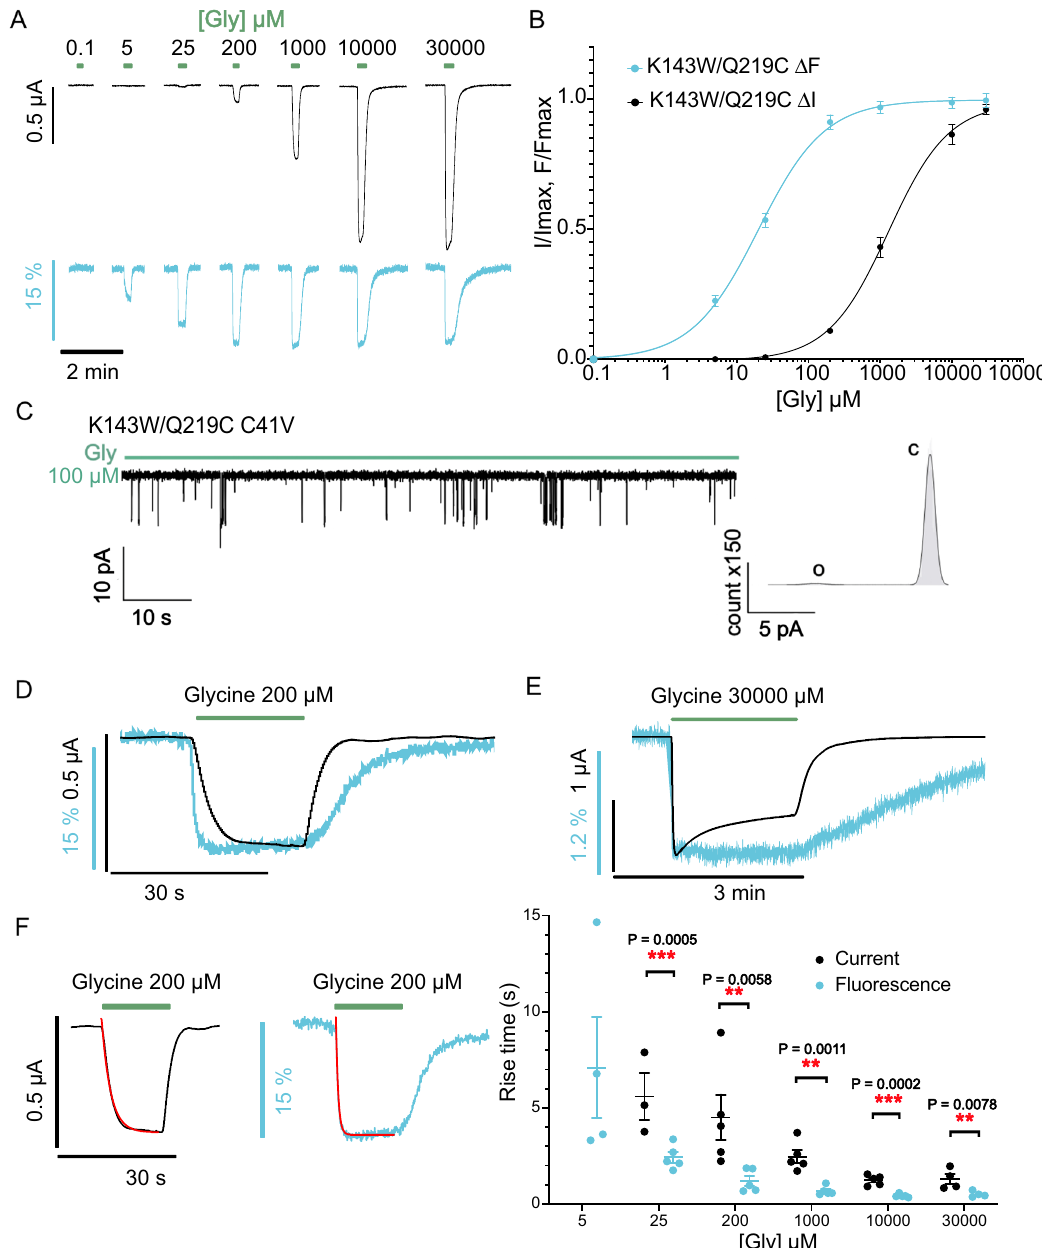
Fig. 2 | Electrophysiological and fl uorescence characterization of K143W/ Q219CsensorbyVCFonC41VGlyR.A RepresentativeVCFrecordingsonoocytes of the mutant labeled with MTS-TAMRA (black for current and cyan for fl uores- cence). Glycine application triggers a current variation and a fl uorescence quenching phenomenon with a maximum fl uorescence variation that reaches 12.1±1.1 % of Δ F/F. At low concentrations of glycine (under 25 µ M), only fl uores- cencequenching isobserved without any current. B Δ I (black) and Δ F (cyan) dose- response curves with mean±SEM values ( n =5). C Left panel: representative trace of single-channel recordings obtained in outside-out con fi guration recorded at − 100mV with concentrations of glycine at 100 µ M. Right panel: histograms of current amplitude representing the closed state (c) and the open state (o). D Superimposition of the current and fl uorescence recordings evoked by 200 µ M